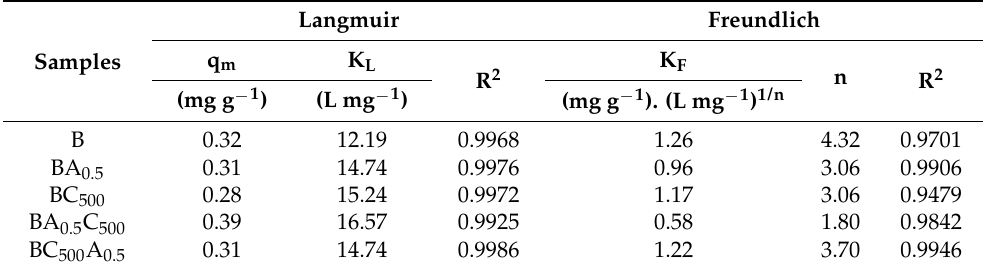
Table 6. Langmuir and Freundlich 2,4-D adsorption isotherm constants.